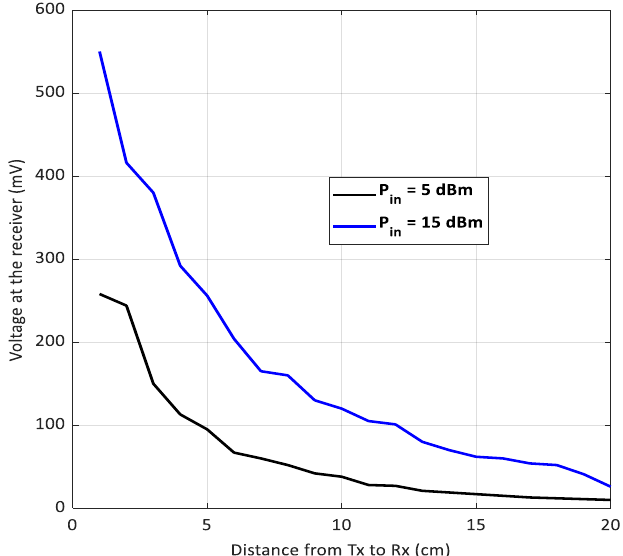
Figure 19. Measured voltage at receiver end for the input transmitter power of 5 dBm and 15